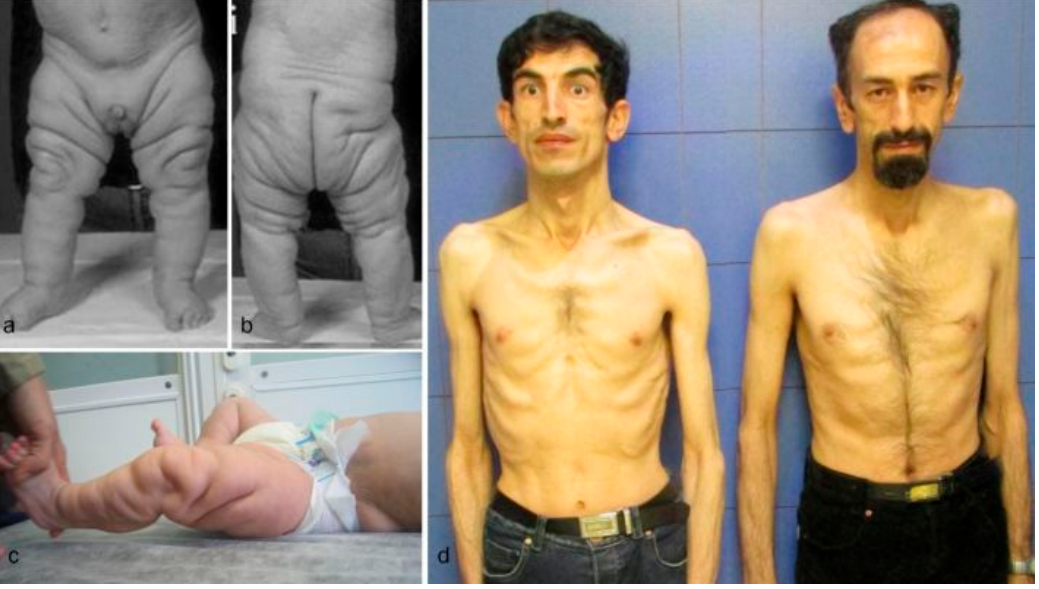
Figure 3. ( a , b ) Abnormal fat distribution seen in cutis laxa IIA; ( c ) it may rarely be seen in GO patients; and ( d ) note lipodystrophy in cases 4 and 5.